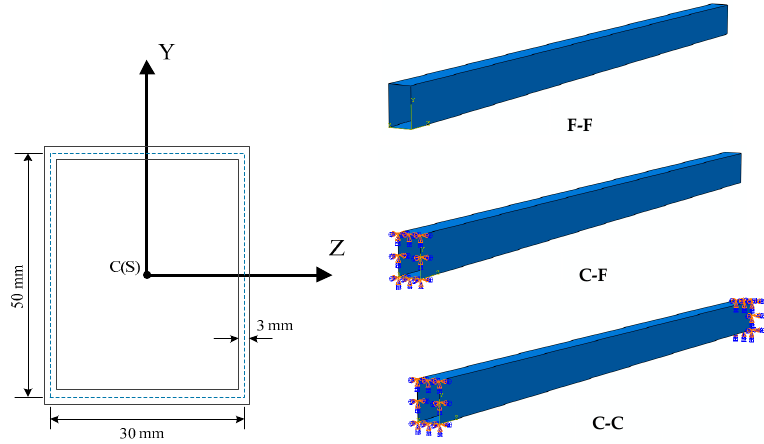
Figure 6. Beam numerical example 2. Table 5. Property details of example 2.